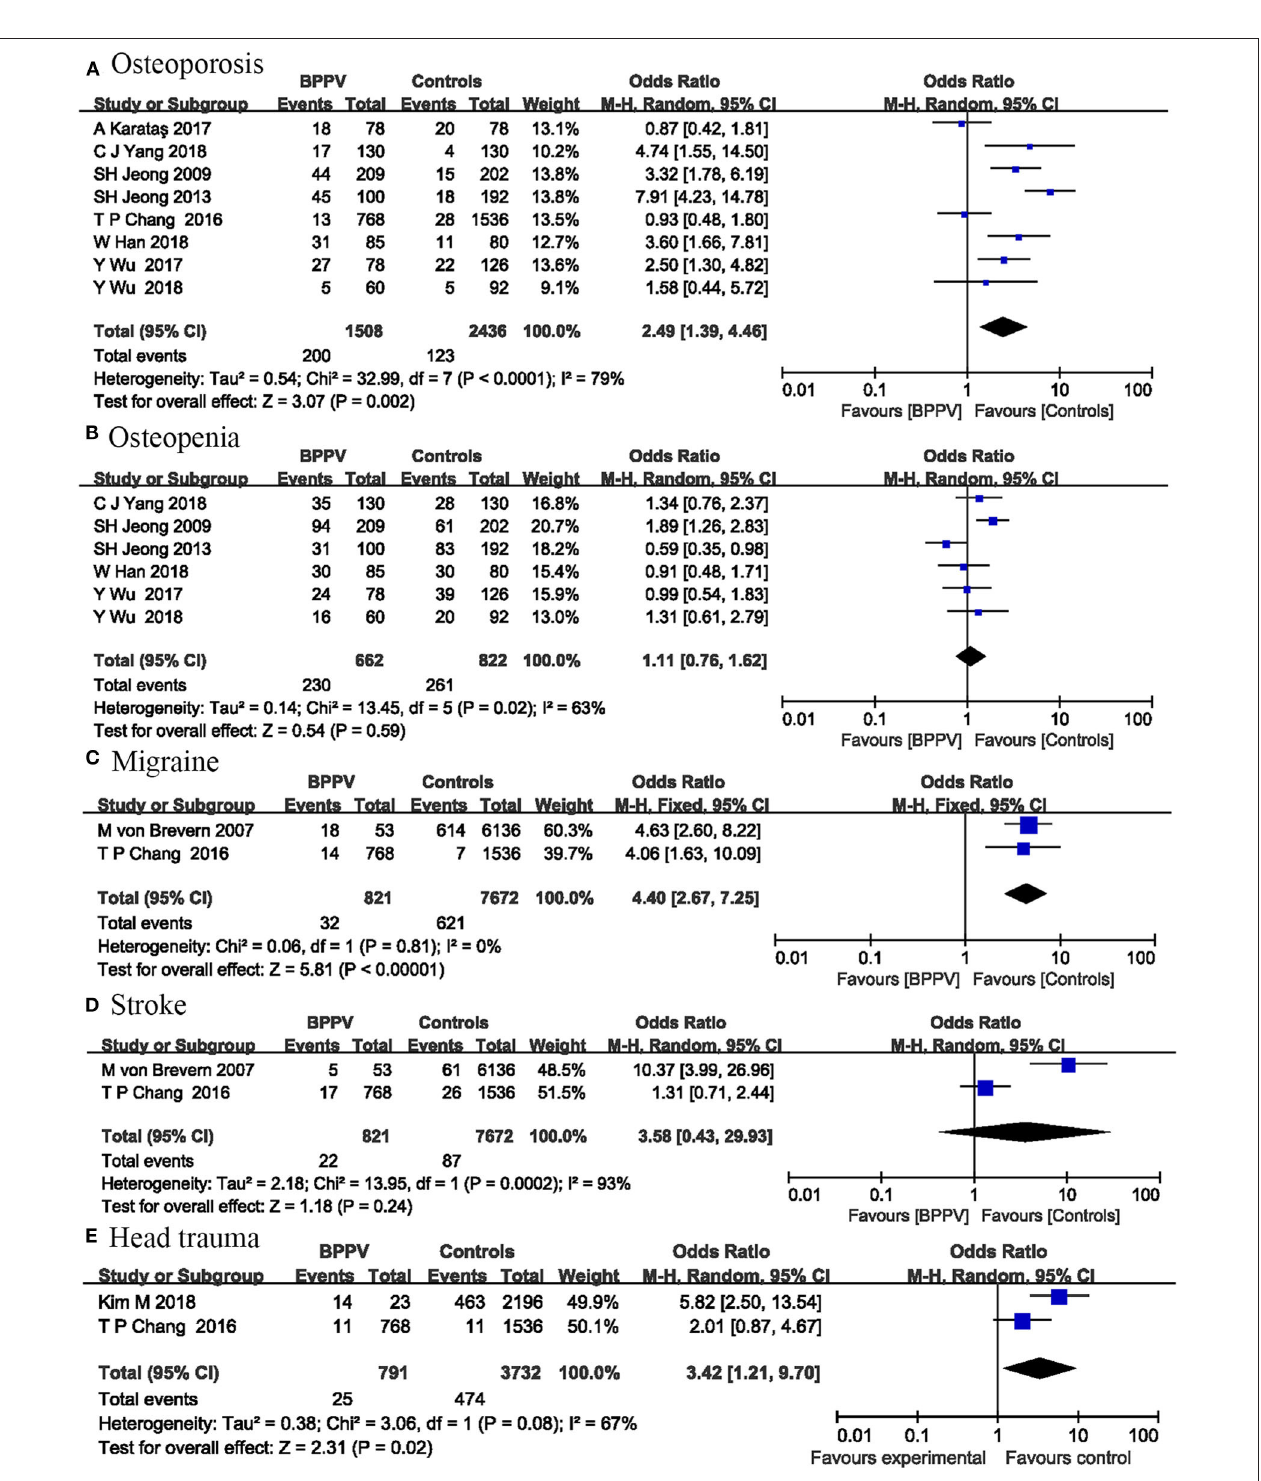
FIGURE 2 | Forest plot of osteoporosis (A) , osteopenia (B) , migraine (C) , stroke (D) , and head trauma (E) . showed that vitamin D supplements can effectively improve why BPPV was more common in postmenopausal women. Thus, symptoms of patients with BPPV (36) and have preventive effects serum vitamin D level may be used for the auxiliary diagnosis of atypical BPPV as a serum predictor. In addition, some studies on BPPV recurrence (37). Hence, vitamin D supplements may